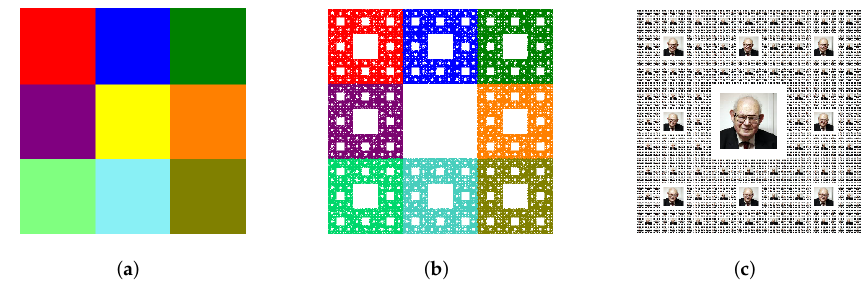
Figure 10. ( a ) Carpet tile, ( b ) Sierpinski carpet, and ( c ) Mandelbrot image